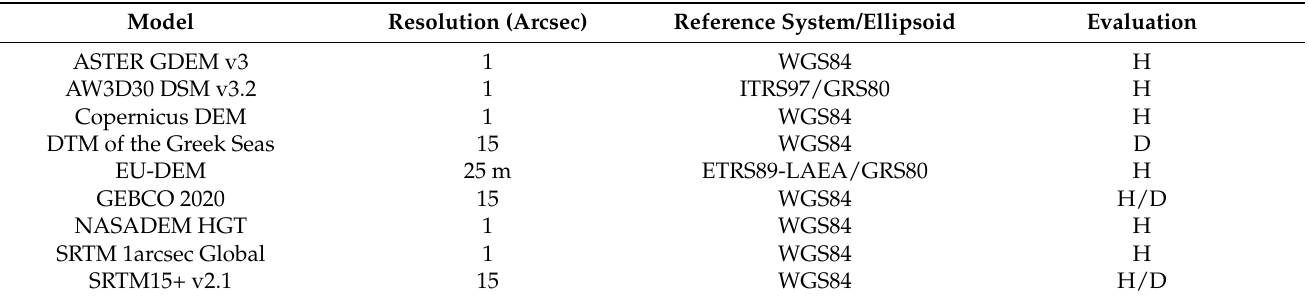
Table 1. Available DEM/DSM/DBM with their resolution, reference system, and the quantity to be evaluated (H: height, D: